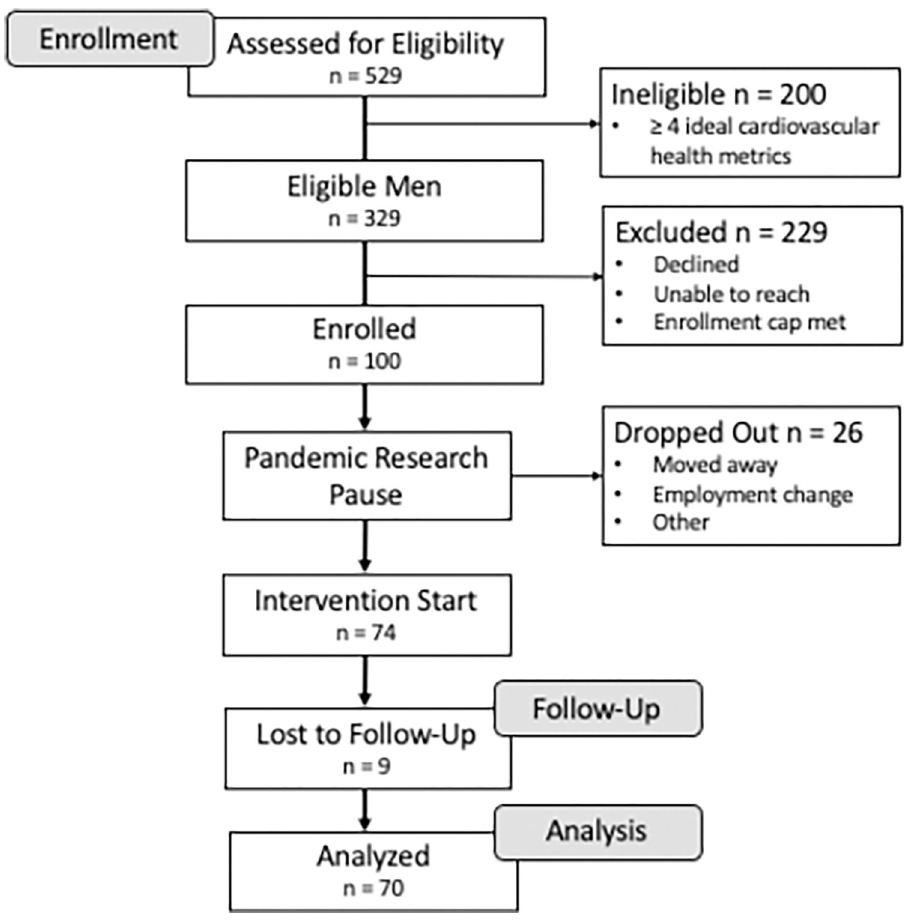
Fig 2. Flow diagram for participants engaged in central ohio pathways